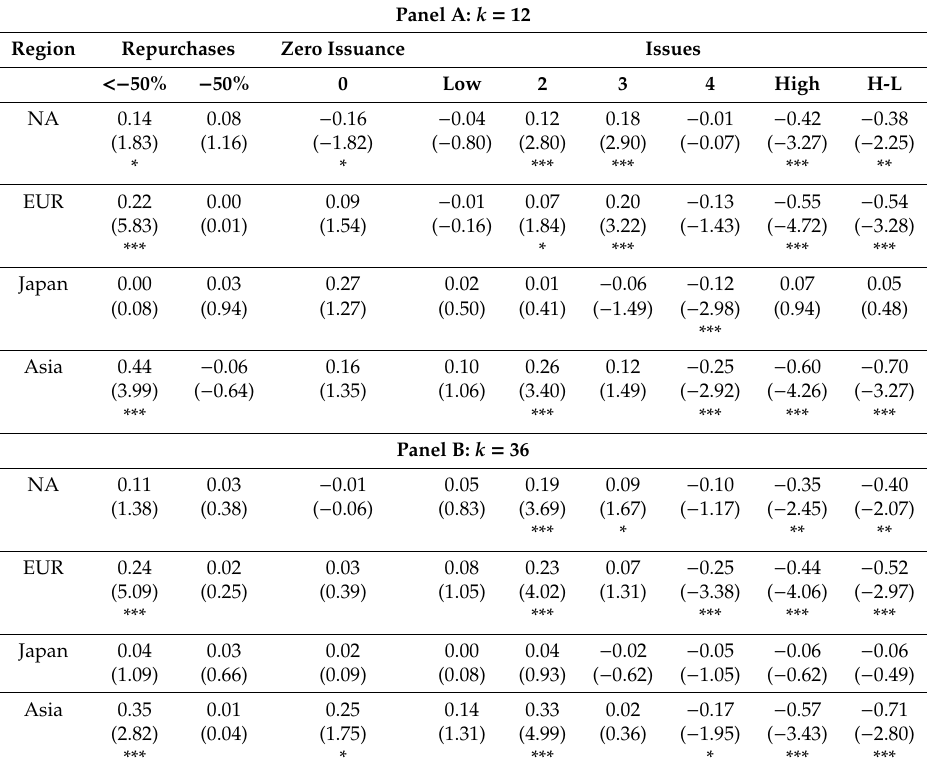
Table 13. Univariate Sorts by Net Share Issues. For North America (NA), Europe (EUR), Japan, and Asia, the cross section of stock returns are regressed on market capitalization, book-to-market, and momentum each month and then sorted into bins on a monthly basis according to net share issues (shares issued less shares repurchased). For negative net share issues, stocks are sorted into two bins relative to the median—large repurchases ( < − 50%) and small repurchases ( − 50%). Stocks with zero net issues are sorted into a separate group, and positive net issues are divided into quintile portfolios using the 20, 40, 60, and 80 percentile breakpoints. Each month, average abnormal returns, residuals from the regression, are computed for each bin and then averaged across all months. Low and high refers to the average return of the lowest and highest net issue portfolio, respectively. ‘H-L’ is the di ff erent in return between the high and low portfolios. All values in parentheses are Newey–West t-statistics. Panel A computes net share issues over 12-month intervals, while Panel B computes net share issues over 36 months. *** / ** / * indicates significance at the 1, 5, and 10% level, respectively.